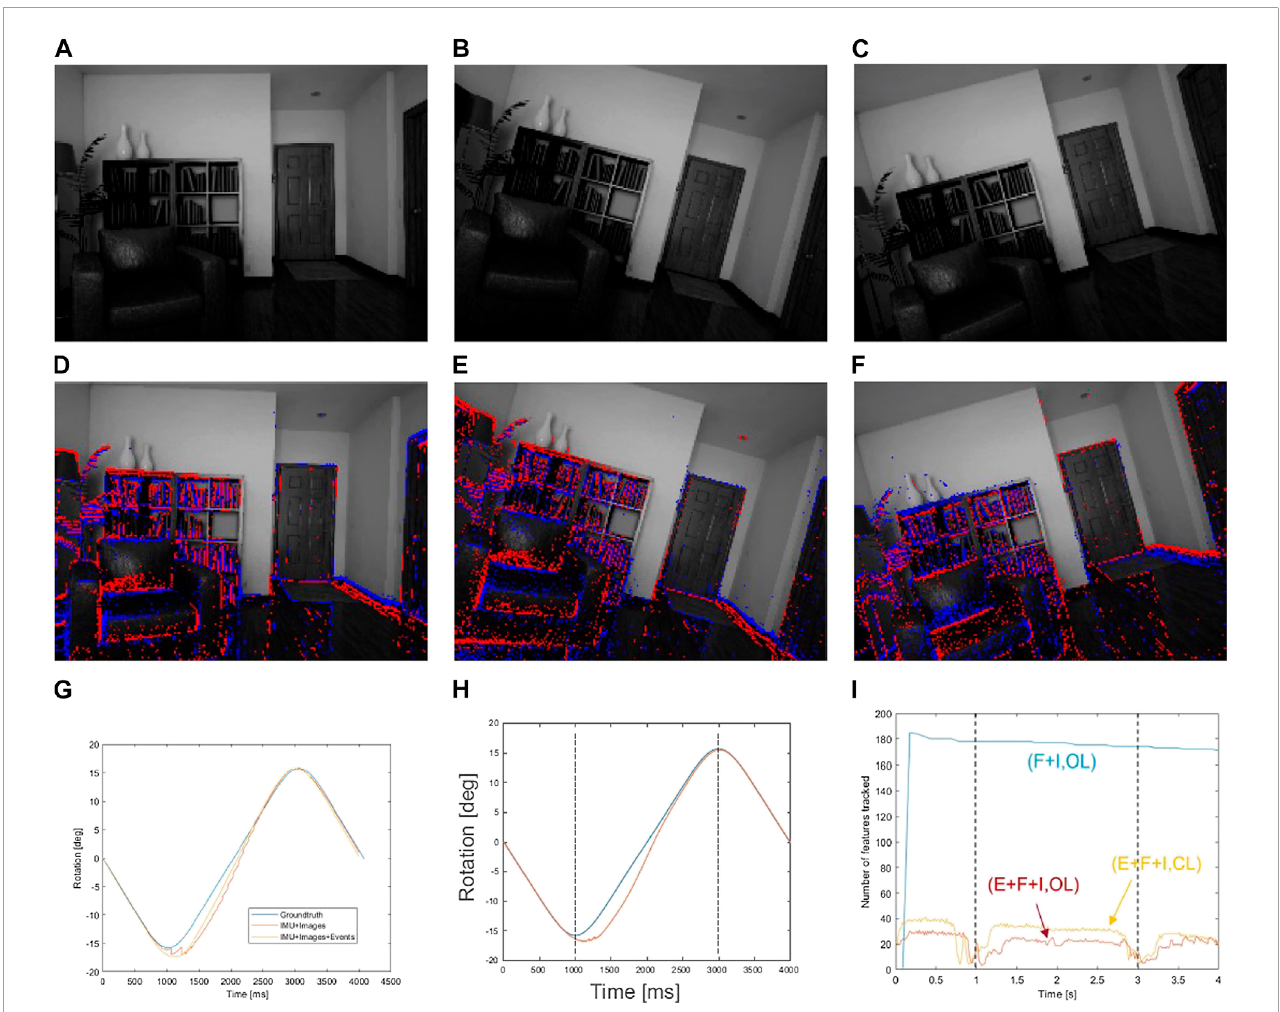
FIGURE 5 (A–C) show the evolution of the rotation along time, with rotation movement towards both sides on the z -axis. (D–F) show the same instants, but with the generated events superimposed. This input was generated using ESIM. (G) shows a comparison between the groundtruth (blue), the conventional approach (orange), and the event approach, open loop (yellow). (H) shows the comparison of the groundtruth (blue) with the closed loop approach (orange). (I) shows the evolution of the number of features for each approach used. Baseline (frames + IMU) is shown in blue. Event approaches, using events, frames, and IMU, are represented using red (open loop) and orange (closed